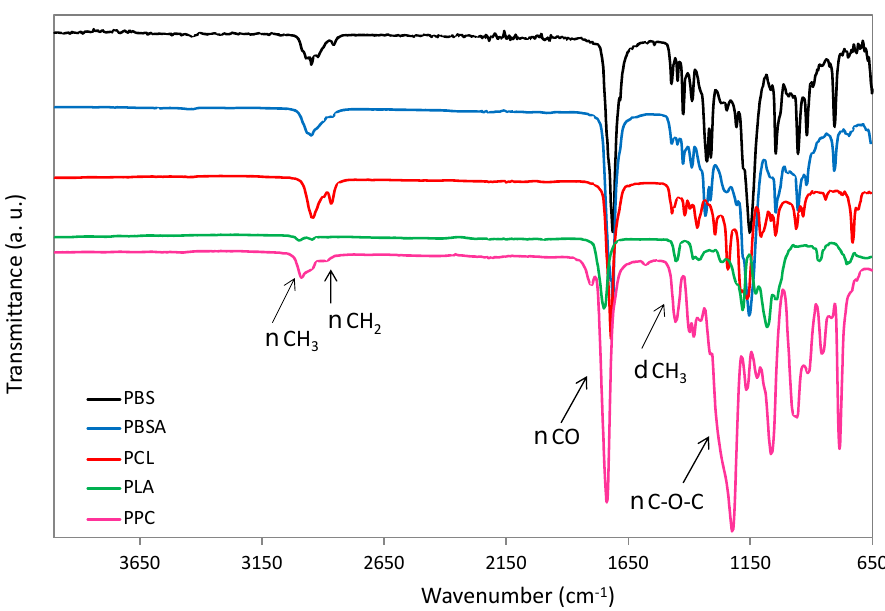
Figure 2. ATR FT-IR curves of PBS, PBSA, PCL, PLA and PPC. Table 3. Main results of the 24 h degradation test performed on the different polyesters (PBS, PBSA, PCL6500D, PCL6800D, PLA and PPC) with the different enzymes. * indicates that the degradation of the polymer film has not occurred; 100% indicates a complete degradation of the polymer occurred in the time indicated between parentheses.